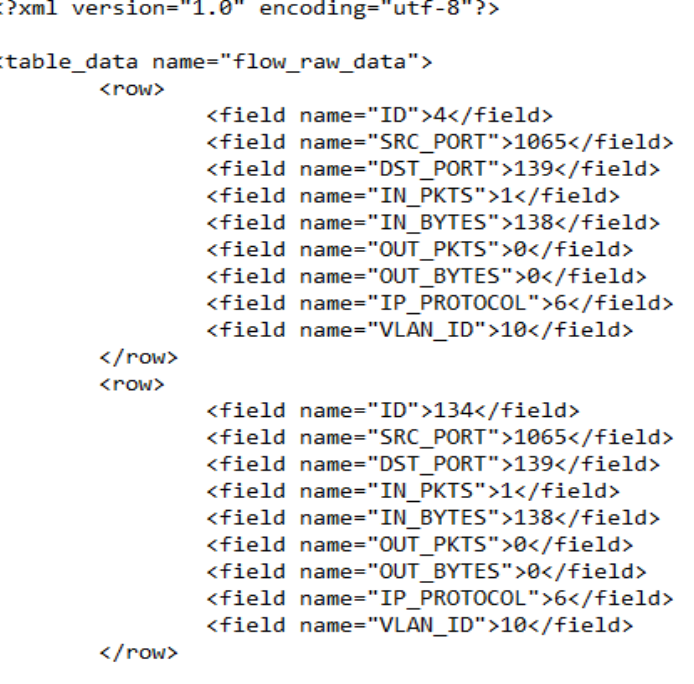
Figure 5. TCP protocol metadata schema.